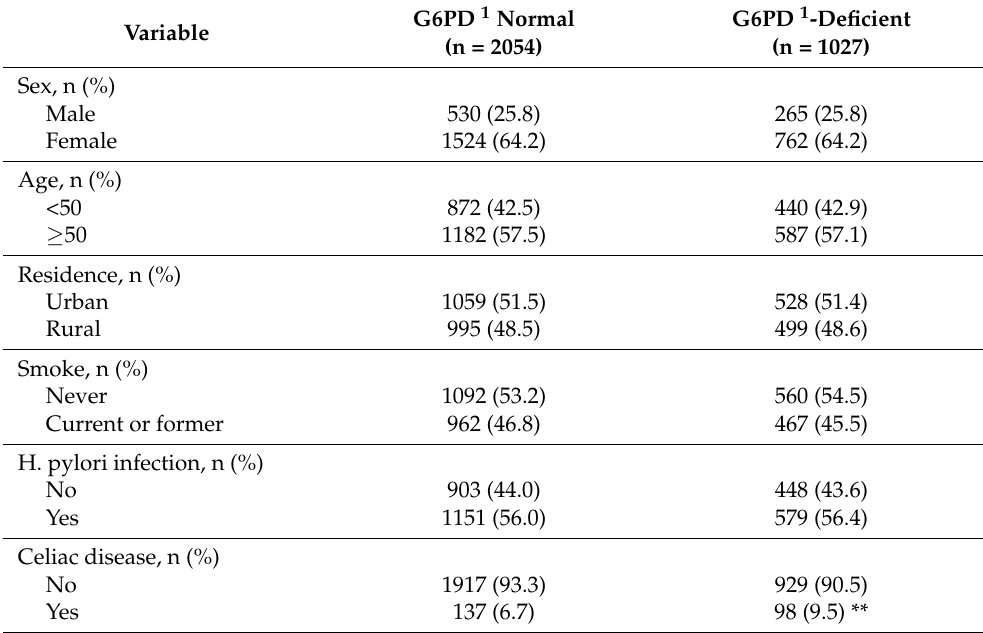
Table 2. Propensity score 2:1 between 1027 G6PD-deficient subjects and 2054 matched subjects with normal enzyme activity.